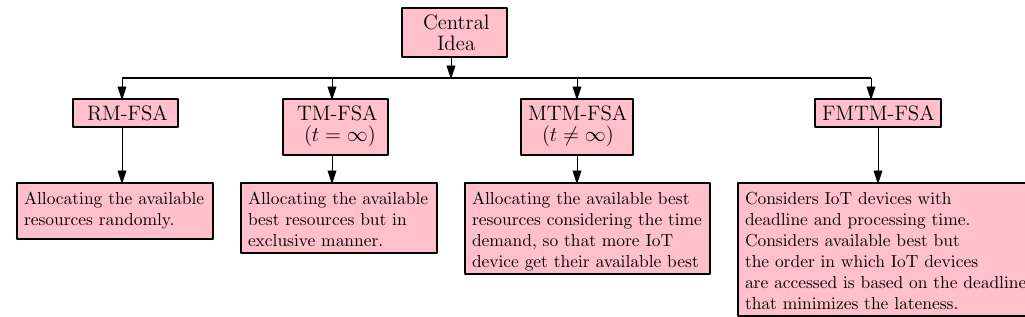
Figure 2. Comparison between the previous framework and the framework presented in this paper.